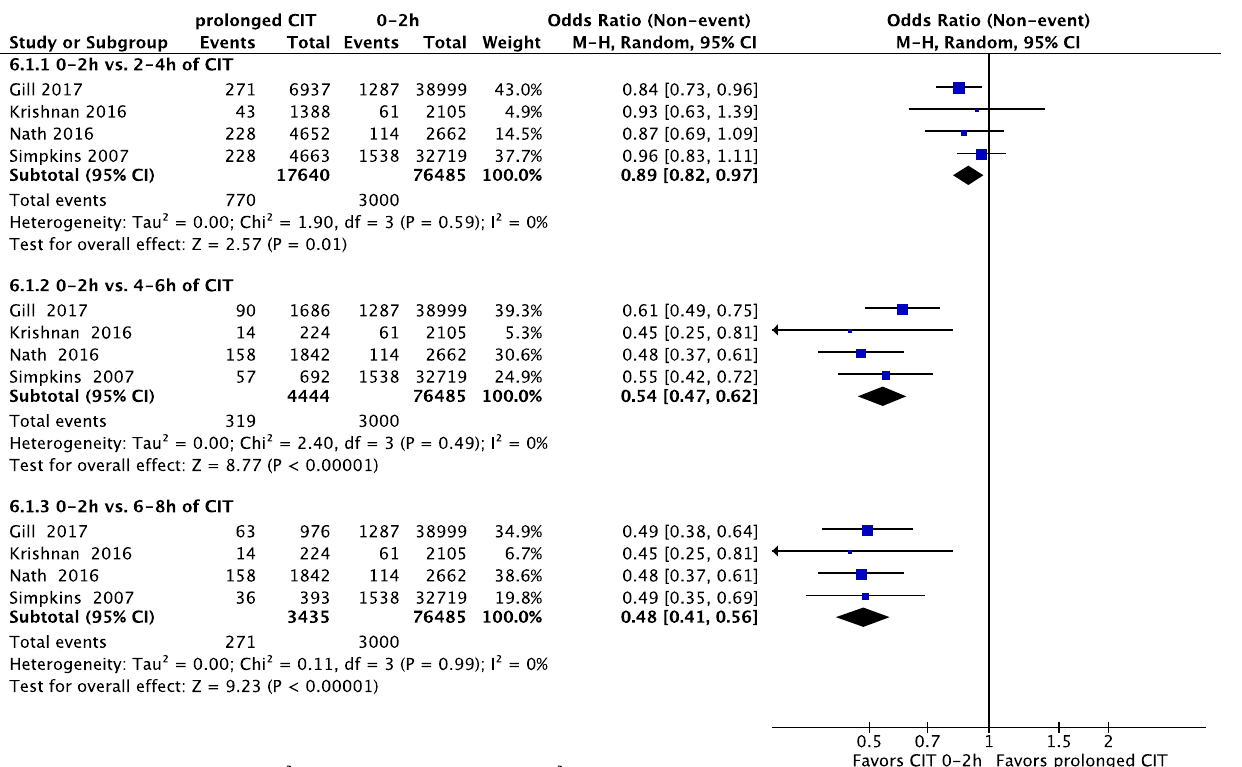
Figure 3. The incidence of DGF in 0–2 h (reference) of CIT versus 2–4, 4–6 and 6–8 h of CIT. CIT: cold ischaemia time; DGF: delayed graft function.